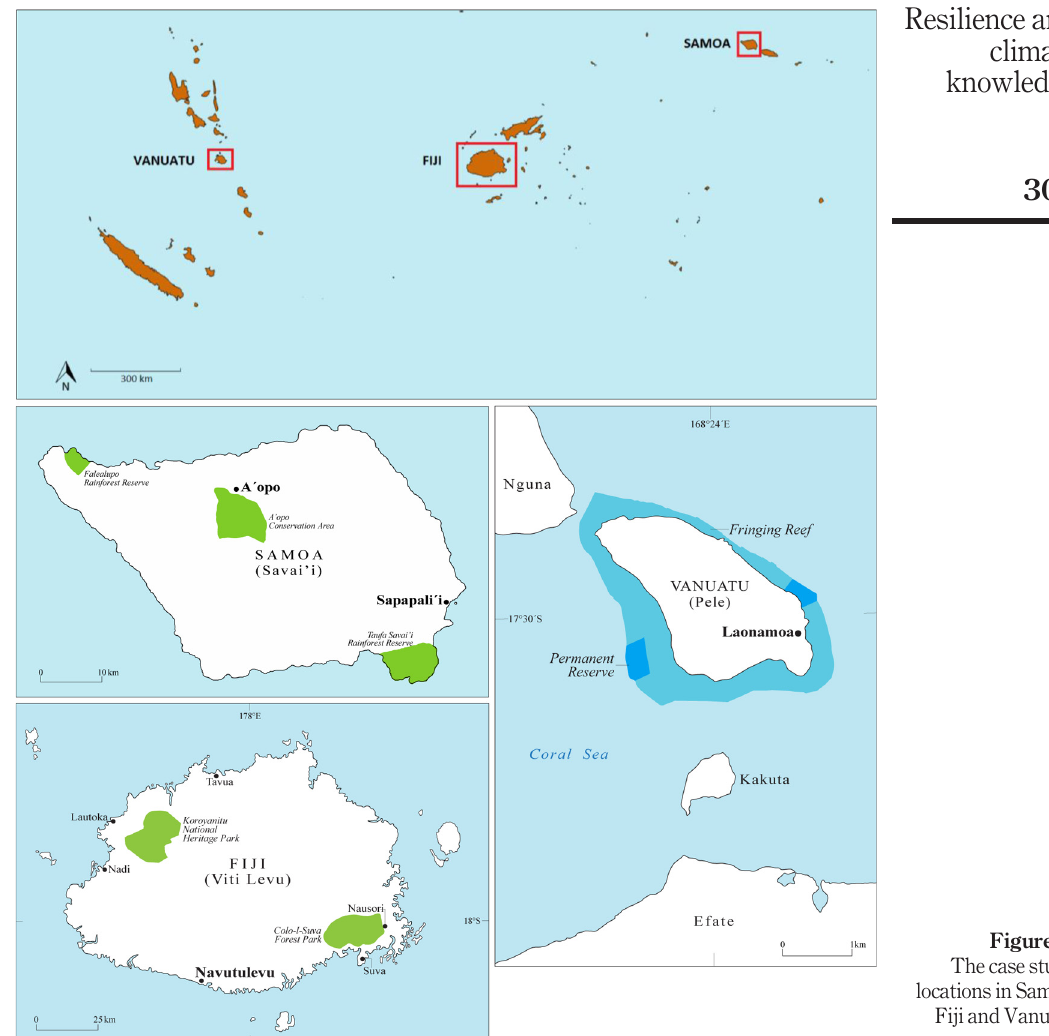
Figure 1. The case